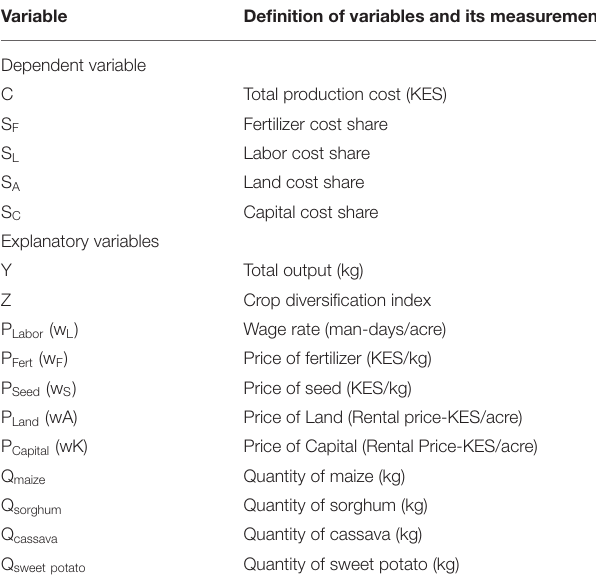
TABLE 2 | Description of model variables for effect of crop diversification on variable cost structure. Variable